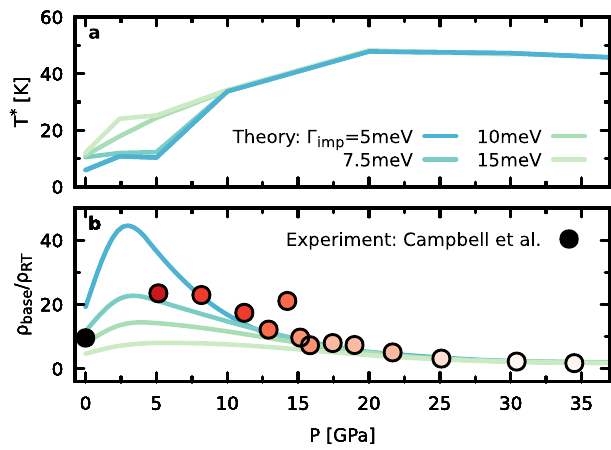
Fig. 3 Crossover temperature T * and resistivity ratio. a In fl ection temperatures T * as a function of pressure for different impurity scatterings Γ T * slightly depends on imp (lines shaded blue to green). At low pressures, Γ P = 5GPa, the onset of saturation is insensitive to the imp ; above magnitude of impurity scattering. b Ratio of the resistivity at base temperature, ρ base , and at room temperature (RT), ρ RT , for different impurity scatterings Γ imp (lines shaded blue to green), compared to experiment (circles; from ref. 7 ). In the simulation (experiment 7 ) the base and room temperatures were 1 and 290 K (2 and 300 K), respectively. The overall trend of the resistivity ratio with pressure is independent of the strength of impurity scattering. We fi nd the best quantitative agreement with the experiment for Γ imp ~